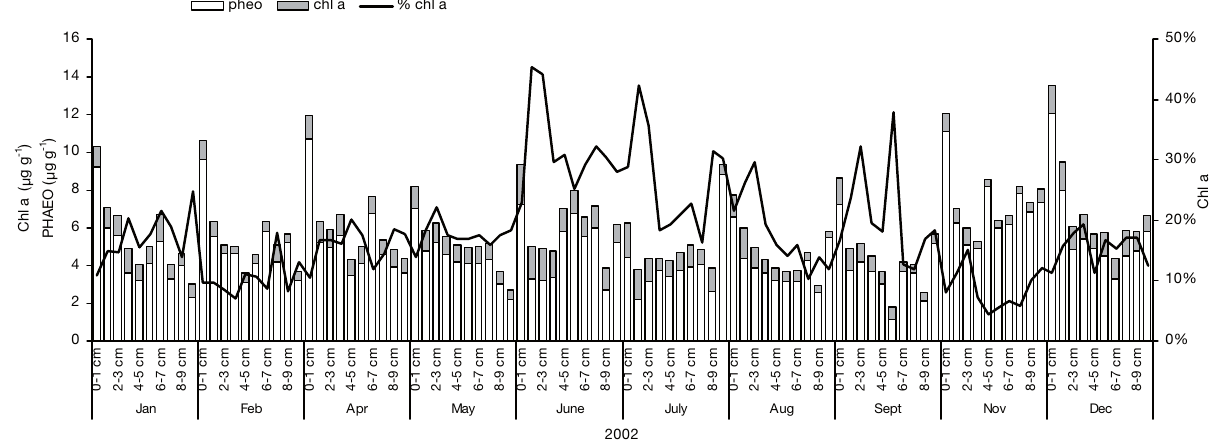
Fig . 3. – concentrations of phytoplankton pigments (µg g -1 ) in sediment samples from depths of 0-10